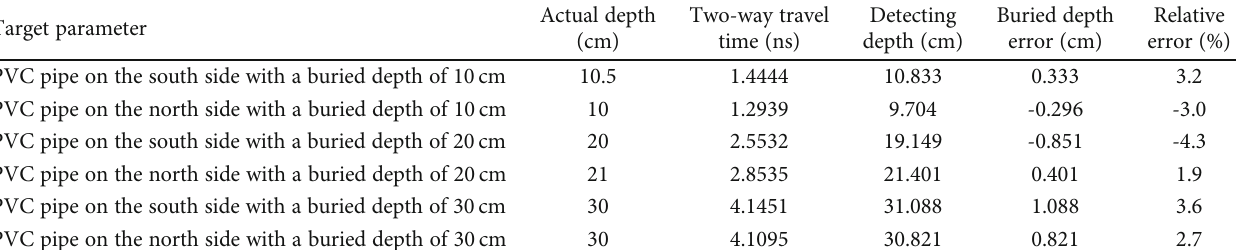
Table 7: Error analysis table of radar detection test for PVC pipes with di ff erent depths.